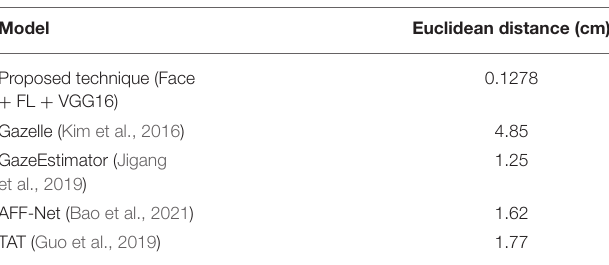
TABLE 5 | Proposed technique vs other techniques.